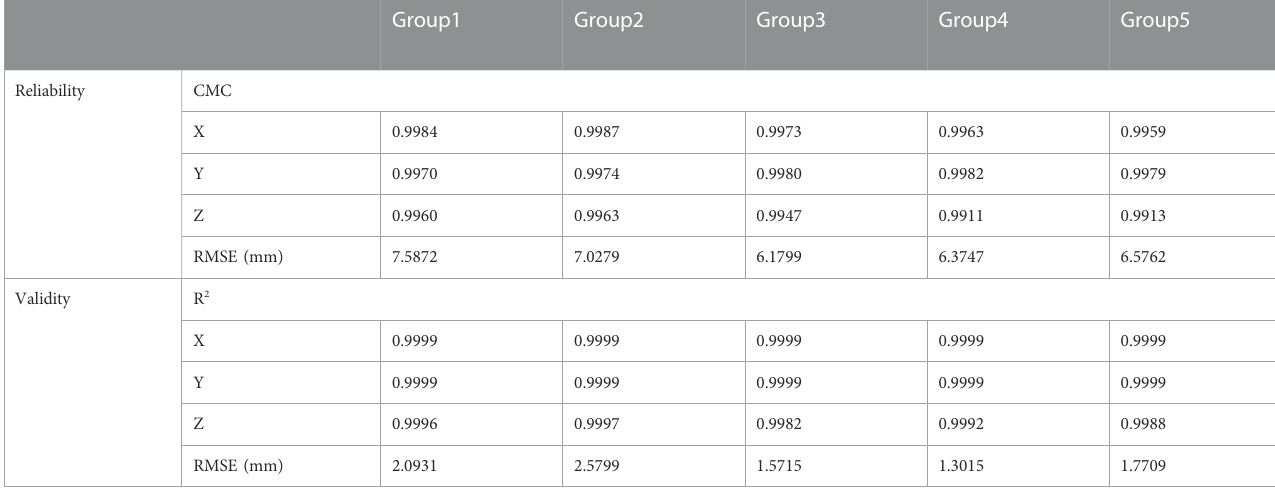
TABLE2Resultsofthereliabilityandvaliditytest.Thecoef fi cientofmultiplecorrelation(CMC)andtherootmeansquarederror(RMSE)forreliabilitytestbetween-day difference were presented, and the R 2 of linear fi t method (LFM) and the RMSE for validity test between the novel method and Qualisys system are